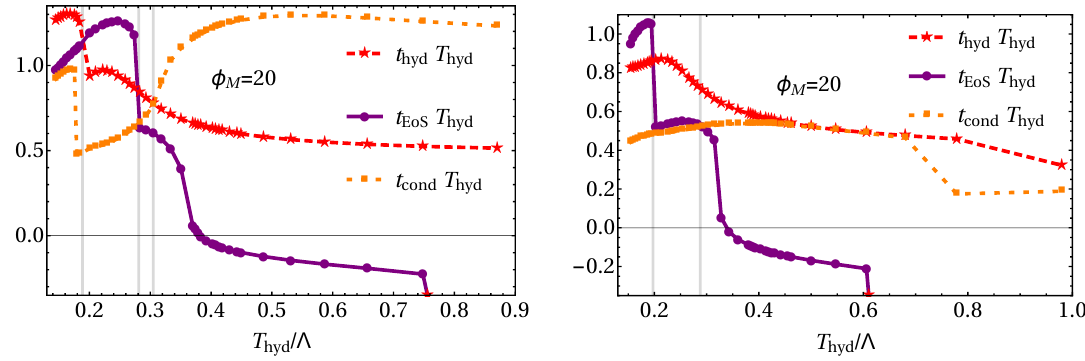
Figure 17 . Hydrodynamization, EoSization and condensate relaxation times for collisions with (cid:22)! = 0 : 30 for the model with (cid:30) = 20 with the \10%" criterion of equations (5.3), (5.6) and (5.7) M replaced by a 15% criterion (left) or a 20% criterion (right). Regions with di(cid:11)erent orderings are separated by grey vertical lines. (These numerical simulations were performed with a 1%